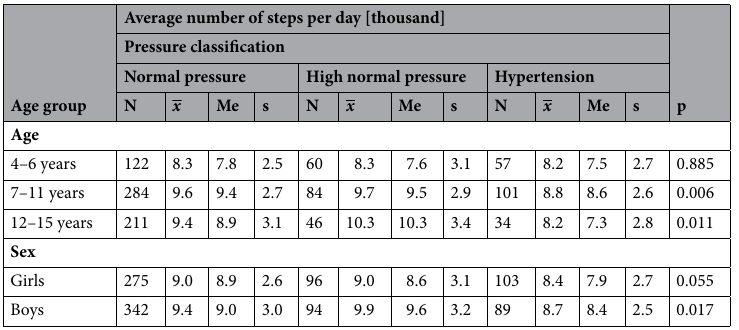
Table 2. The average number of steps per day and hypertension by age and sex of subjects. N number of participants, x average, Me median value, s sample standard deviation, p probability level, Normal blood pressure—below the 90th percentile for sex, age and height; High normal arterial pressure—value of systolic pressure and/or diastolic pressure between the 90th and 95th percentile for sex, age and height; Hypertension—systolic and/or diastolic pressure value equal to or higher than the 95th percentile for sex, age and height.